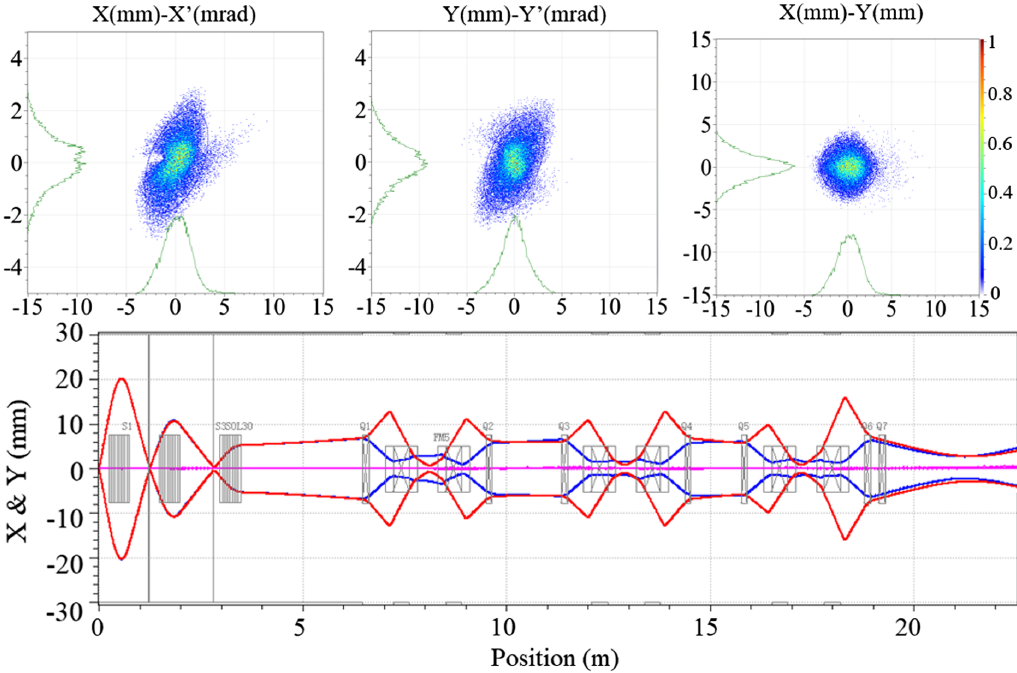
FIG. 6. Upper: simulation results for the transverse phase space at the exit of the vertical beamline. Plots from left to right are the phase space diagrams in the x and y directions, and a cross-section of the beam at the irradiation point. Lower: beam envelope evolution along the z axis. The blue line represents the x -direction, and the red line represents the y -direction.